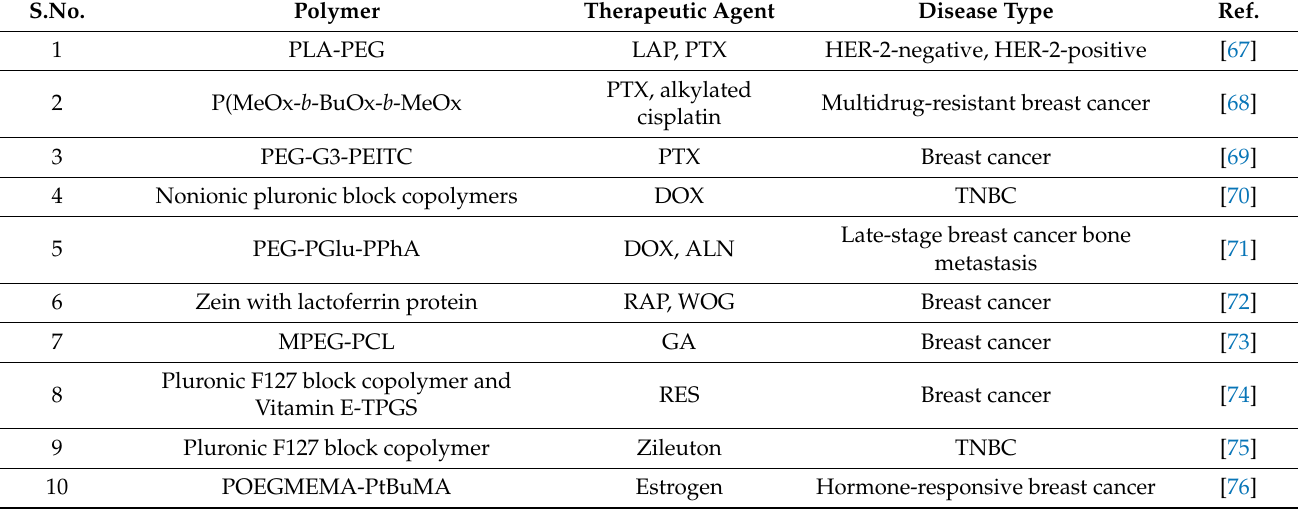
Table 2. List of the different types of PMs developed against breast